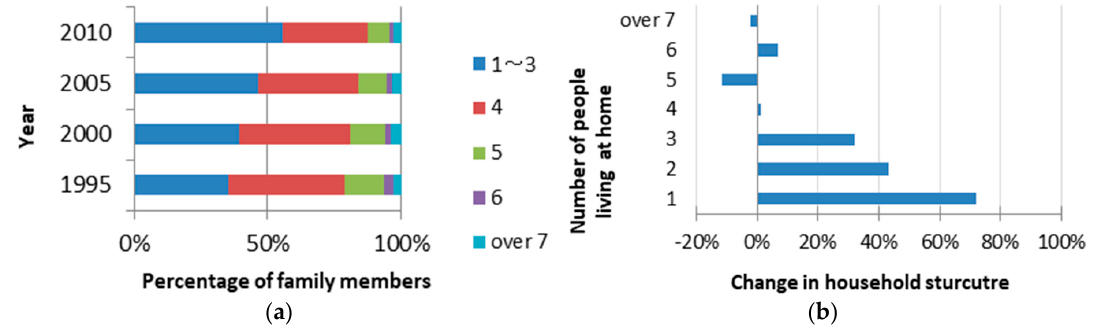
Figure 4. ( a ) Component ratio; ( b ) rate of household structure increase from 2005 to 2010.